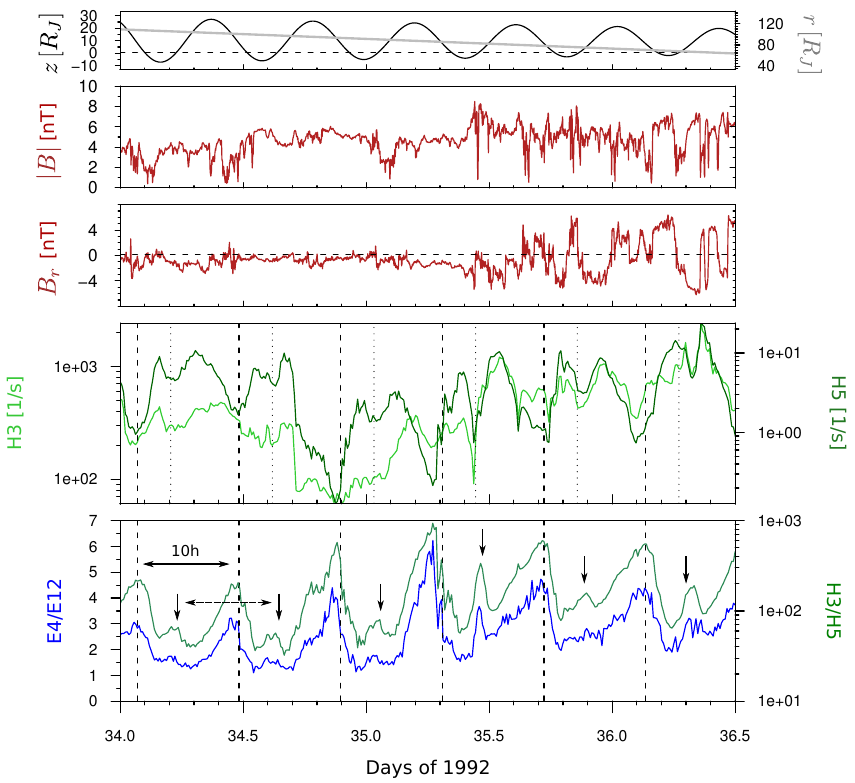
Fig. 2. Ulysses data for the spacecraft’s inbound path from day 34 to 36.5. The bottom panel shows the KET E4/E12 and HET H3/H5 ratios as a proxy to the spectral index of MeV electrons followed by the H3 and H5 counting rates. The next two panels show the radial component of the magnetic field as well as the magnetic field magnitude. The top panel shows the distance of the spacecraft from the magnetic equator (rigid disc, black) and from the planet (grey) in Jovian radii. Besides the well-known clock-like modulation (“major peaks”, indicated by the dashed lines), a second periodicity of ∼ 10h associated with low magnetic latitudes is apparent and indicated by the vertical arrows (“minor peaks”).